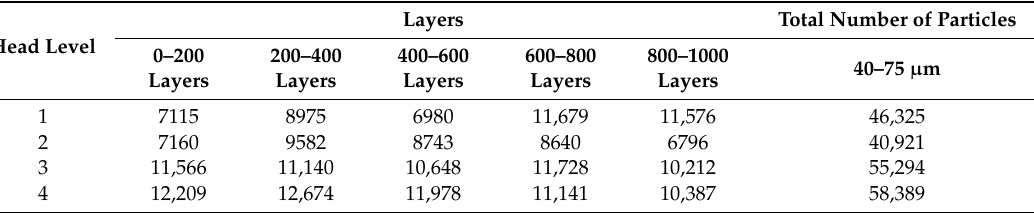
Table 18. Variation in the number of fine particles percolated with the 70% fine particle content (40–75 µ